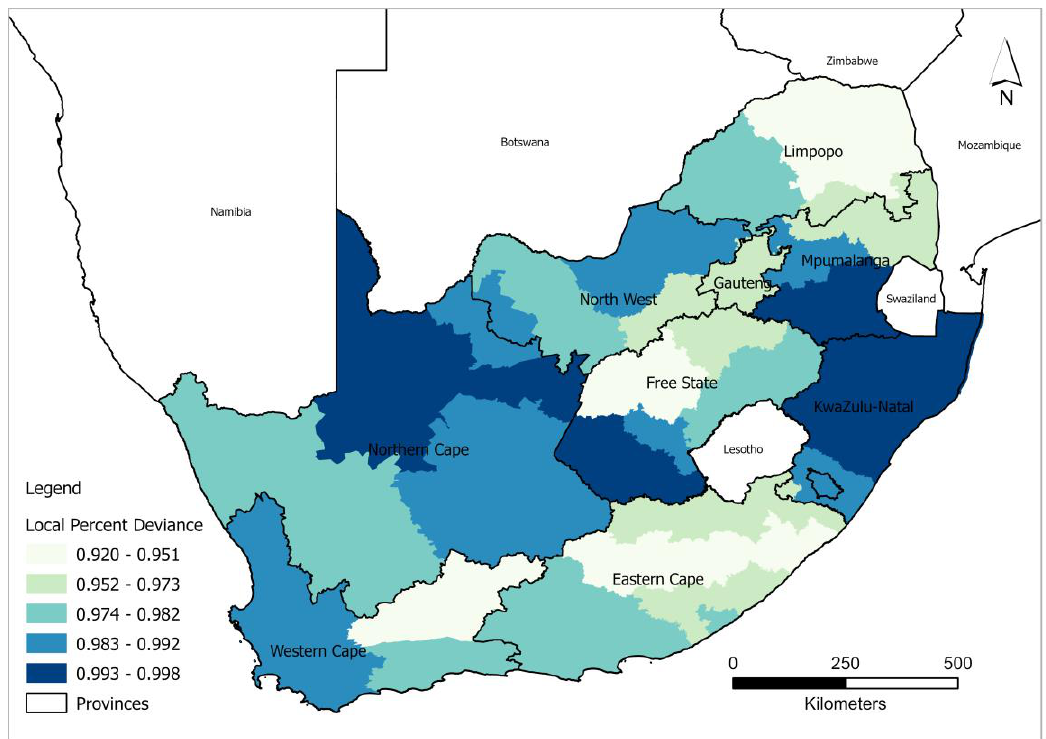
Figure 4. Spatial distribution of local percent deviance from the GWRP model.